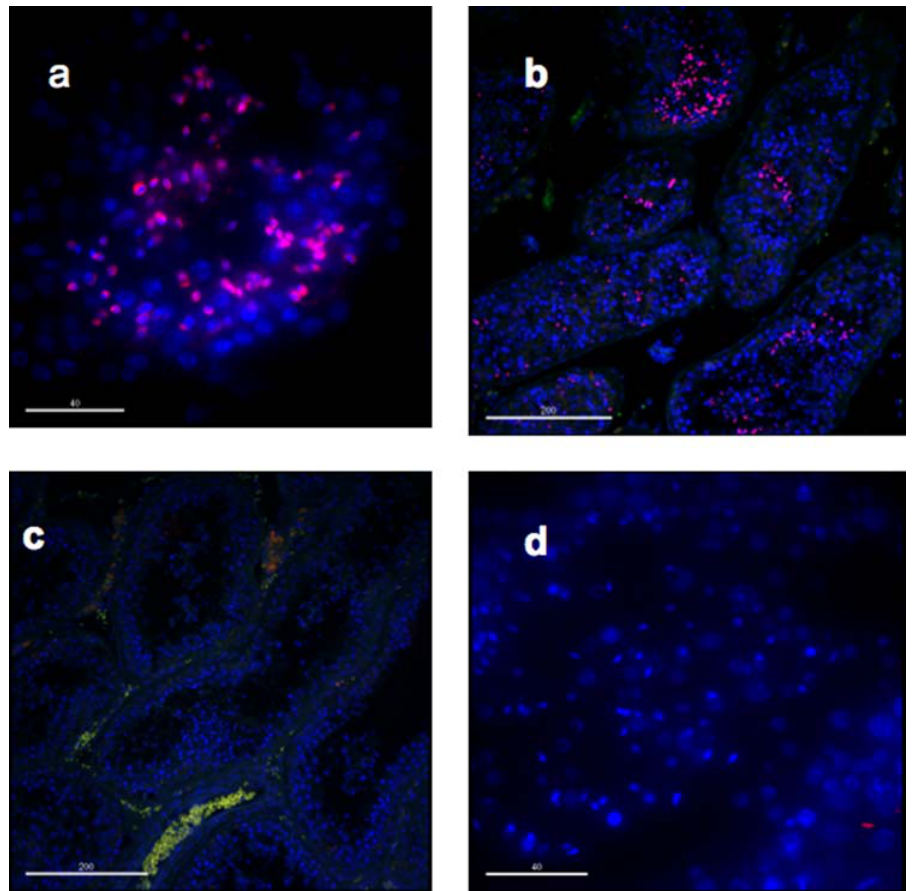
Figure 5. Immunostaining of SPANX-N ( a, b ) and the negative control ( c, d ) at low ( a, c ) and high magnification ( b, d ) on normal human testis sections (bars indicated). The staining is clearly specific for late spermatids and spermatozoa (in pink, a, b ). Autofluorescence (i.e., non-specific signal, a, b ) is also detectable in red blood cells and can be recognized by the overlapping signals in the green and red wavelengths. Nuclei are counterstained with DAPI (in blue).